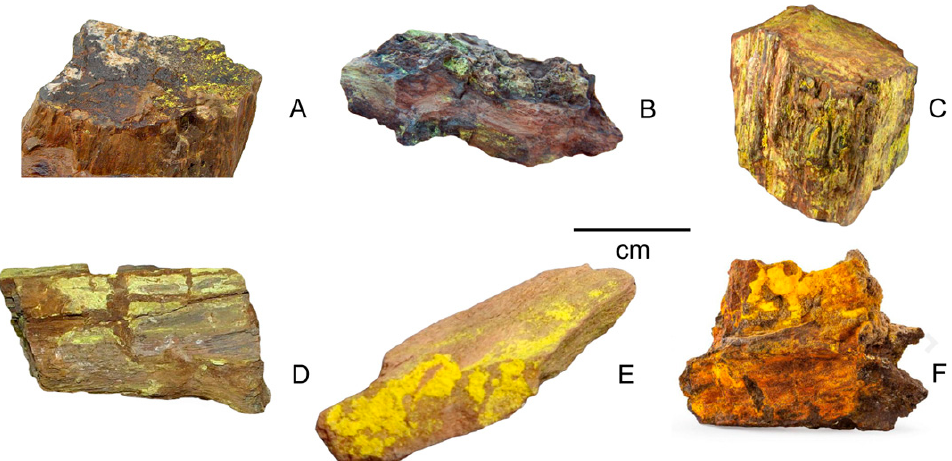
Figure 4. Uranium minerals in fossil wood from mines in the American Southwest. ( A ) Uraninite, Henry Mountains (UT). ( B ) Uraninite with secondary alteration, Reuben Weeks Mine, Cainville Wash (UT). ( C ) Uranophane, Happy Jack Mine, San Juan County (UT). ( D ), Carnotite, La Sal Valley, (CO). ( E ) Carnotite, Grand County (UT). ( F ) Zippeite, Happy Jack Mine, San Juan County (UT).